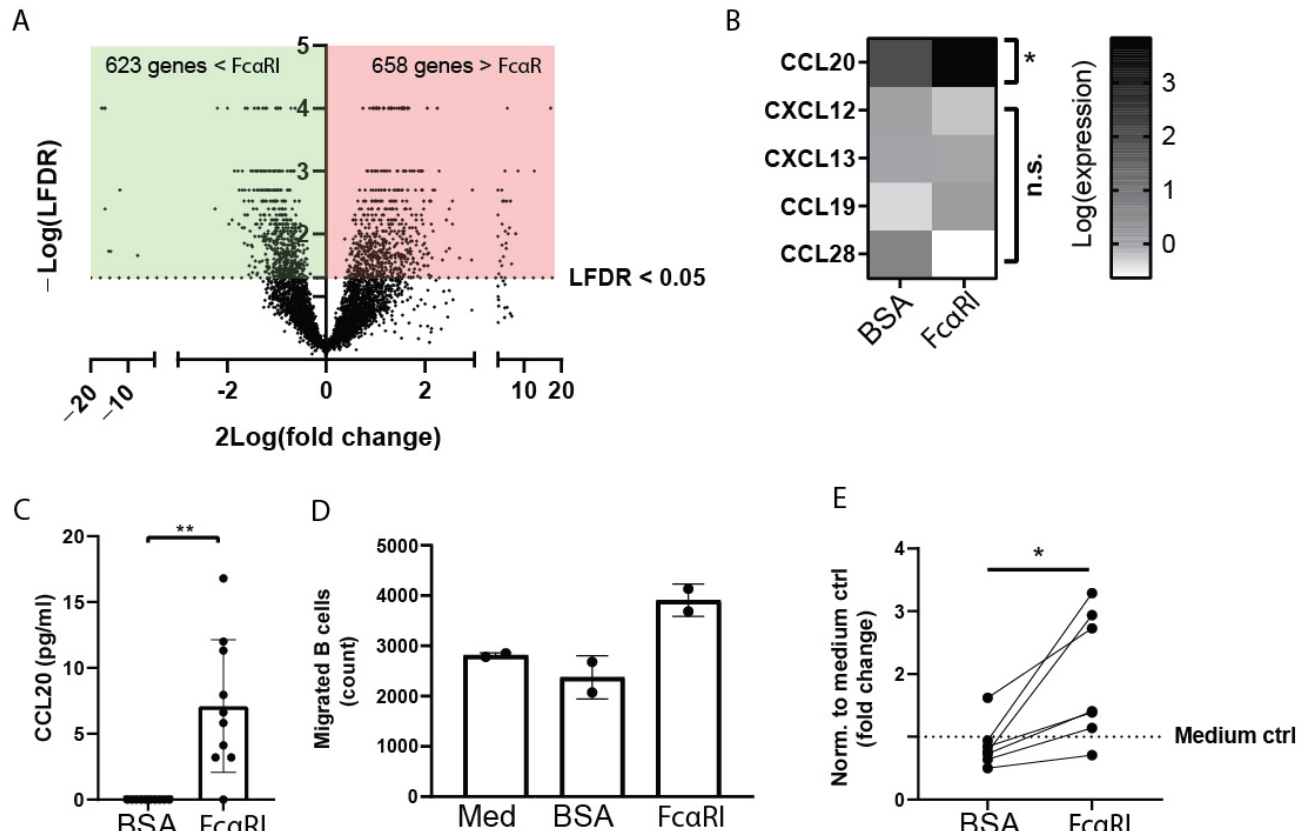
Figure 2. Fc α RI-stimulated monocytes produce the chemokine CCL20 and attract B lymphocytes. ( A , B ) RNA sequencing of monocytes stimulated with either BSA- or IgA-coated (activating Fc α RI) beads was performed. ( A ) Volcano plot of all genes expressed by monocytes with BSA- or IgA- coated bead stimulation. The x -axis represents log 2 of the fold change, while the y -axis represents the local false discovery rate (lfdr). ( B ) Heat map of log-transformed RNA-seq counts of human peripheral monocytes after stimulation with BSA- or IgA-coated (activating Fc α RI) beads. Genes above an lfdr of 0.05 are considered significant. Coloring represents log expression of expressed genes. ( C – E ) Peripheral monocytes were stimulated with BSA- or IgA-coated (activating Fc α RI) beads for 24 h. Luminex was performed on the supernatant of stimulated monocytes to determine ( C ) C–C motif chemokine ligand 20 (CCL20). ( D , E ). Supernatants were placed in the bottom compartment of transwell chambers, while upper chambers contained peripheral B cells. Migration toward lower compartments was determined. ( D ) A representative experiment is shown (technical duplicate). Med: medium only as negative control. ( E ) Quantification of fold increase of B-cell migration toward supernatants of monocytes stimulated with BSA- or IgA-coated (activating Fc α RI) beads. B-cell migration to medium was used to normalize for each donor was normalized. Data are presented as the mean ± SD. n.s. = not significant. Wilcoxon matched rank test, ** p < 0.01; Student’s t -test, * p <